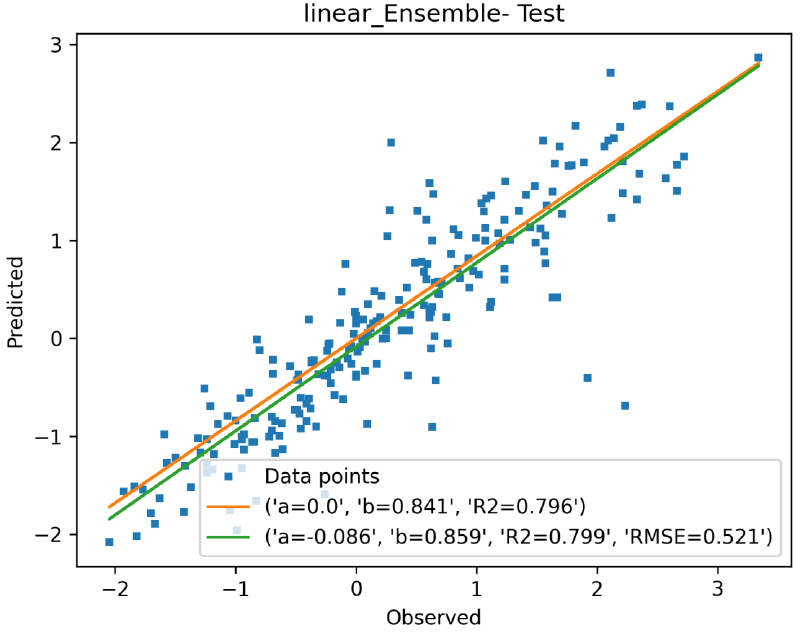
Figure 5. QSAR for pIGC50 against T. pyriform : observed vs. predicted biological activities for the test set while using the linear ensemble model. The correlation between each selected molecular fragment and biological activity can be retrieved from the LASSO model. The main MFs and their contributions are shown in Figure 6. The blue MFs have positive values and decrease toxicity. On the other hand, the red-colored fragments, such as the pattern 1-hydroxy-4-methoxy-benzene (upper right in Figure 6), increase the compound toxicity. That particular result could be associated with the similarity of this MF to the ubiquinol pattern. Therefore, compounds that have this moiety is supposed to interfere with vital processes to the cell, showing toxic